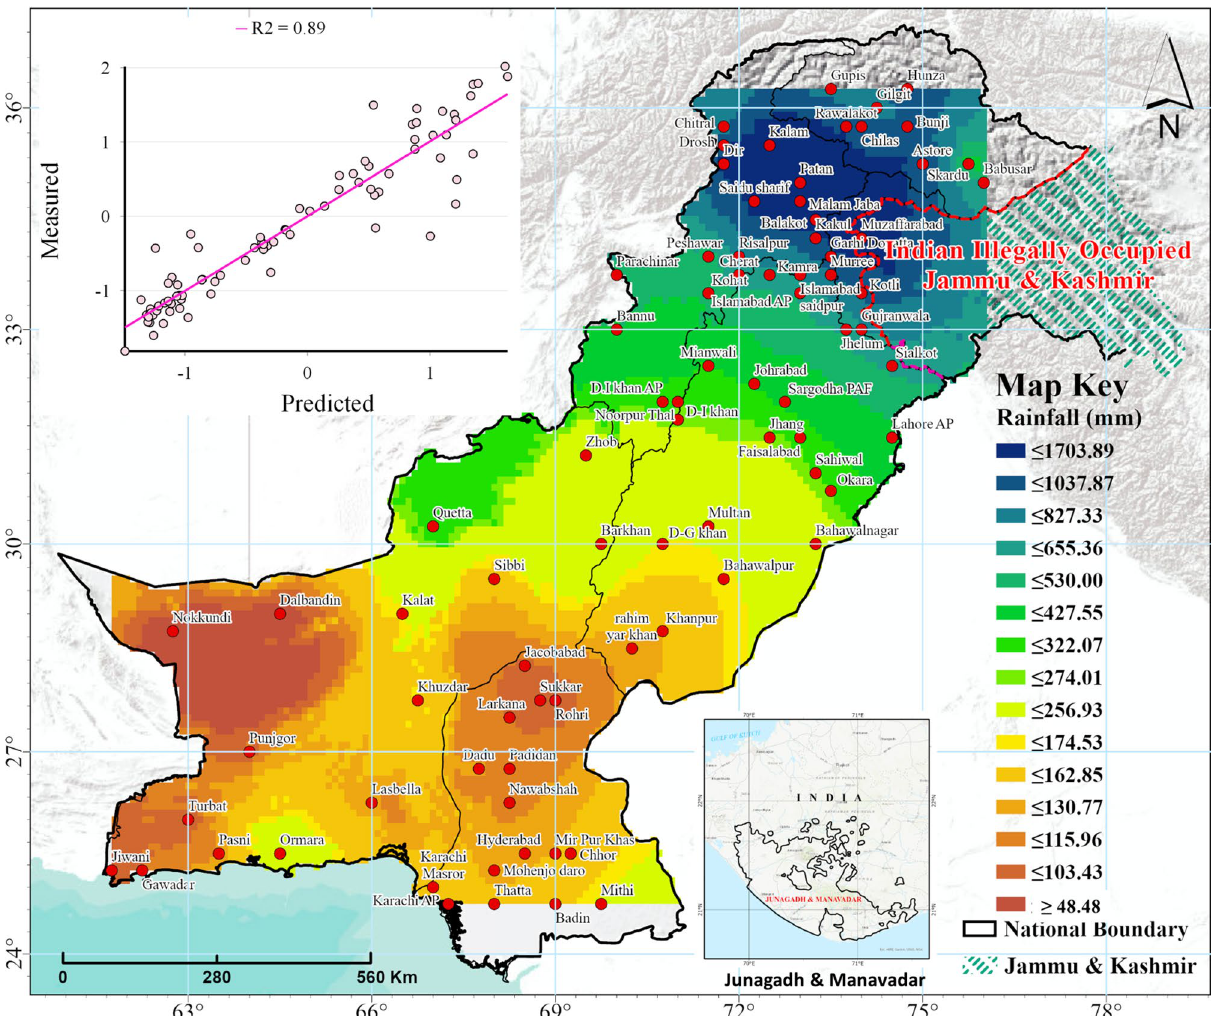
Figure 5. Normal rainfall map of Pakistan based on the empirical Bayesian kriging regression prediction (EBKRP) method for interpolation; the inset scatter-plot shows the measured vs. predicted values. The pink line shows the R2 for the predicted values. The shades in brown represent drier areas (relatively less rainfall) and green-to-blue shades show comparatively wet areas (relatively more rainfall). Red dots indicate the observation stations (n = 82). The map is designed using ArcGIS Pro (Version 2.7) from the Environmental Systems Research Institute (ESRI) by a co-author M.S., available at www. esri. com.